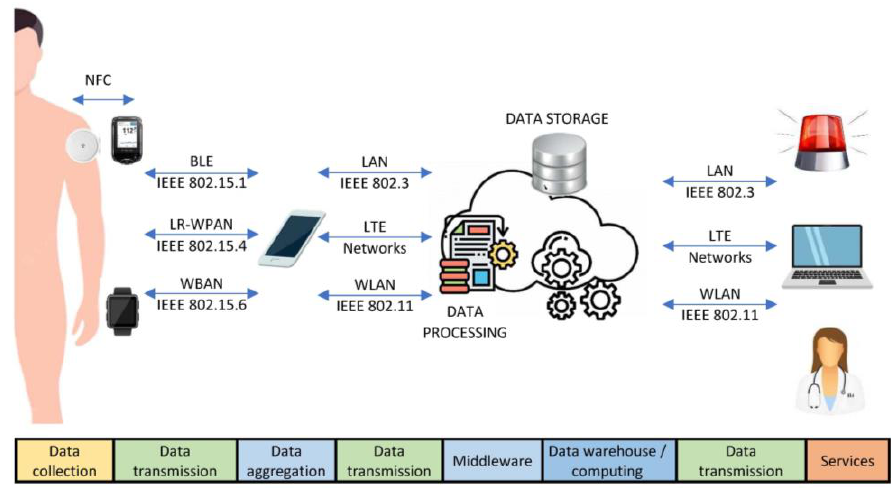
Figure 2. Connectivity ways for DM1 management.